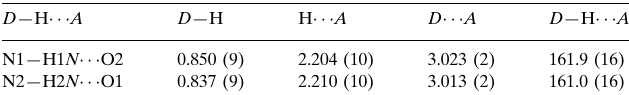
Hydrogen-bond geometry (A˚ , (cid:2)